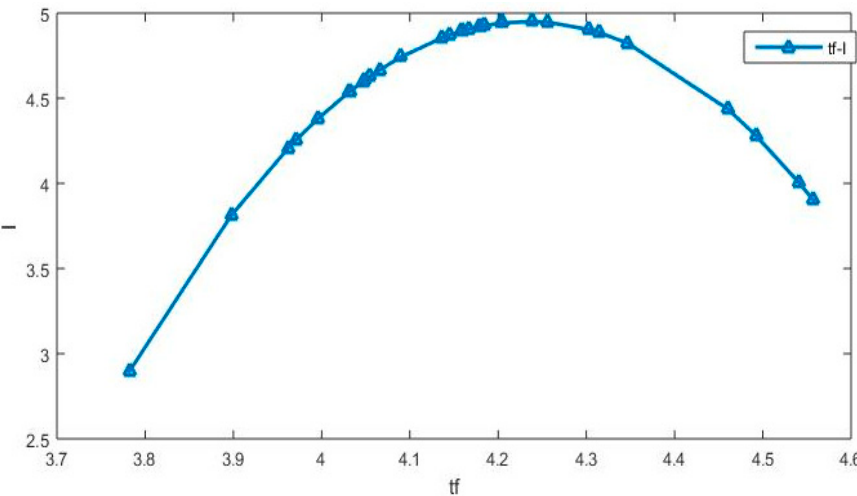
Figure 1. The impact of FinTech development on agricultural NPS pollution.